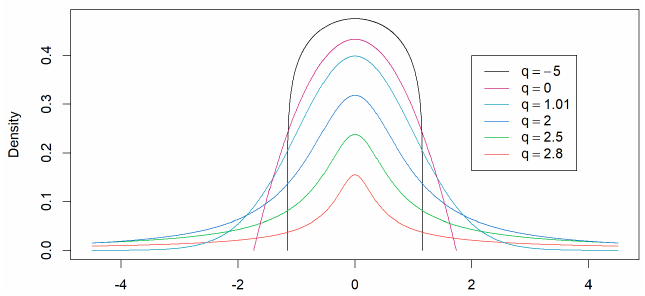
Figure 2. q − Gaussian Distributions.